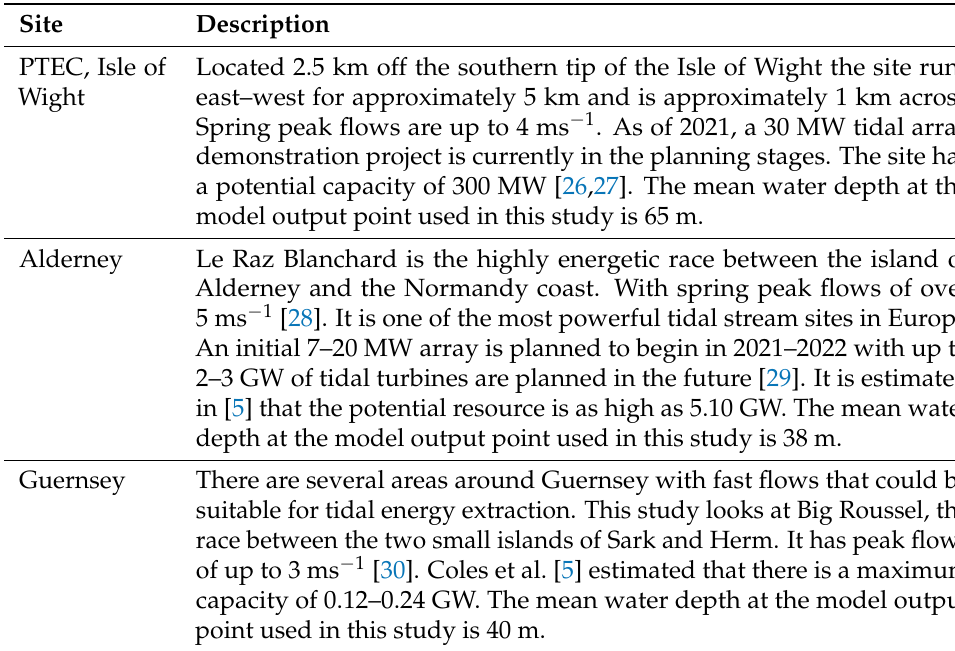
Table 1. Selected tidal energy sitesin the English